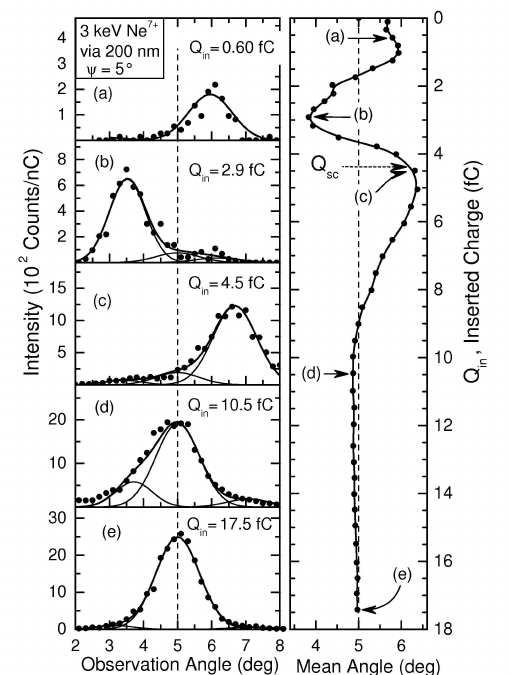
Figure 2. Transmission profiles and mean angle for 3 keV Ne 7 + ions transmitted through capillaries of 200 nm diameter and 12 µ m length. The tilt angle is ψ = 5 ◦ . In the left-hand column the profiles are shown for increasing charge Q in inserted before the curves were measured. The profiles were fitted by a sum of Gaussian functions given as solid lines. The right-hand column shows the corresponding mean emission angle. The labels ( a )–( e ) in the left column correspond to those given in the right column. The arrow labeled Q sc indicates the incident charge for which ∼ 63% of the equilibrium intensity of the transmitted ions is reached. Taken from Ref. [51].